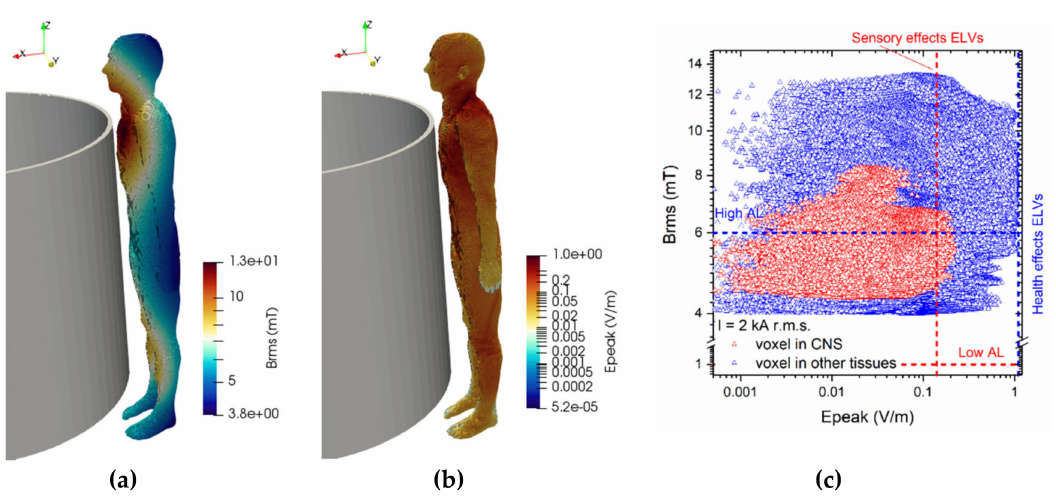
Figure 12. Results for posture B.1. On the left the ( a ) spatial distribution of the B-field amplitude (r.m.s. values, in millitesla) over the body surface. In the middle ( b ) the corresponding spatial distribution of the E-field amplitude (peak values, in volt per metre) over the body surface. On the right ( c ) the distribution of the voxel values.